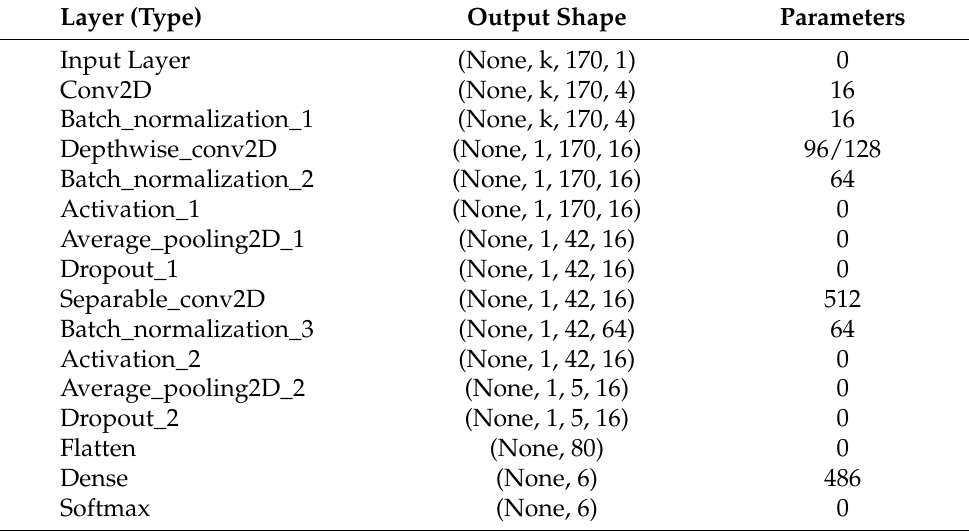
Table 6. EEGNet parameters for processing k discriminant channel signals. This study used k = 6 and k = 8 discriminant